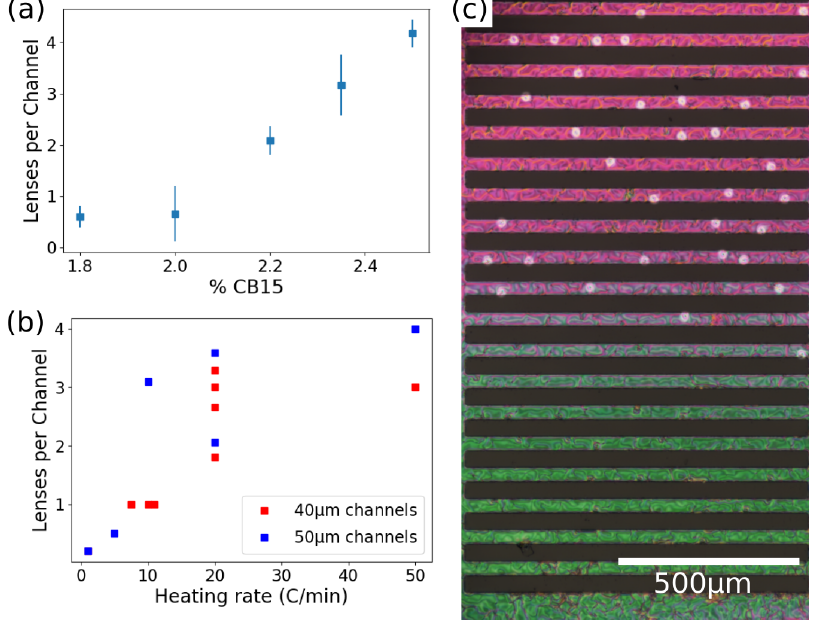
Figure 3. Formation of circular domains. ( a ) Number of circular domains for various concentrations of chiral dopant. ( b ) Number of circular defects formed as a function of heating rate in channels 40 and 50 µ m wide. Every point corresponds to one experiment, in which the system was heated up to 36 ± 1 ◦ C(far beyond the transition temperature) and in which the domains were counted. ( c ) Polarized microscopy image of the channels in the cholesteric phases. The circular domains can be clearly identified as brighter clear circles. It is possible to notice how the channels with the thinner layer (top) have more circular